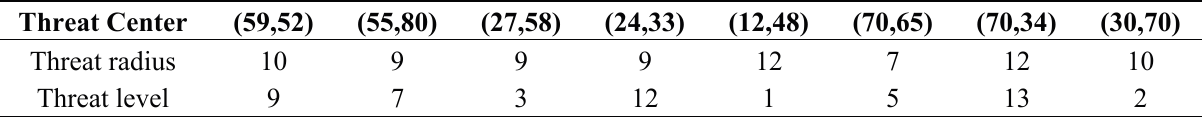
Table 11. Information about known threats for the second test